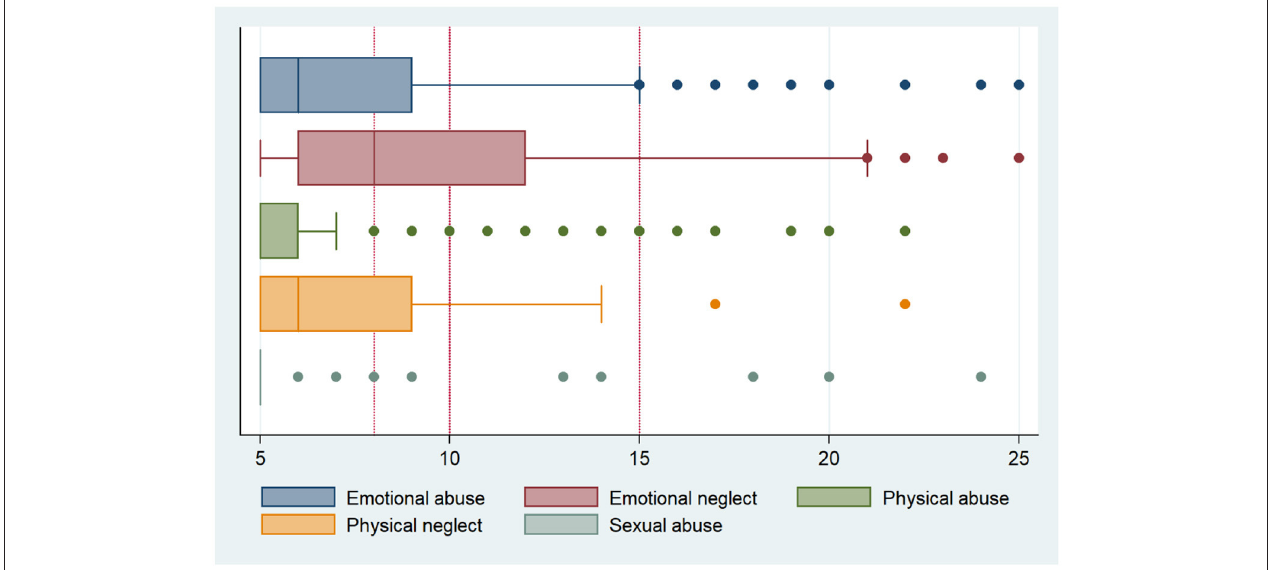
FIGURE 2 | Subscores of childhood trauma questionnaire of patients with pulmonary arterial hypertension.